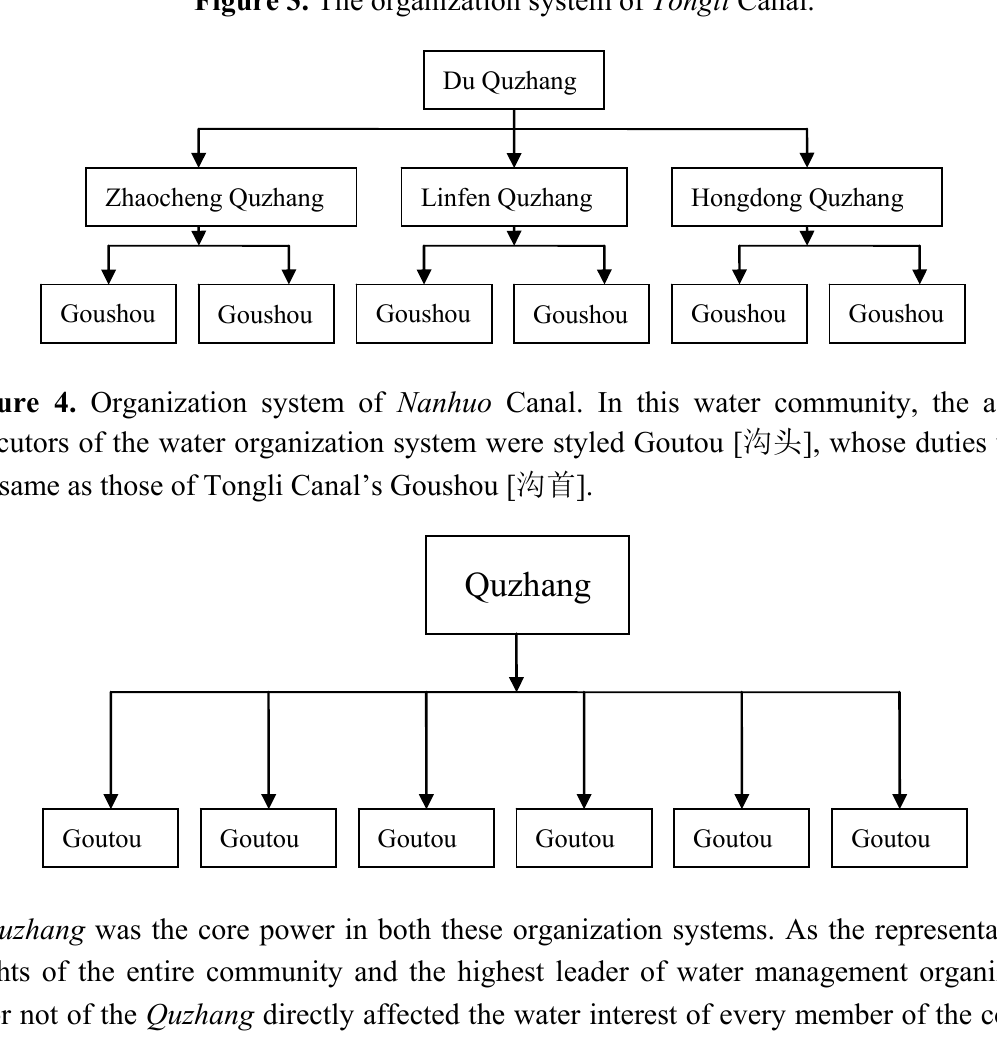
Figure 3. The organization system of Tongli Canal.